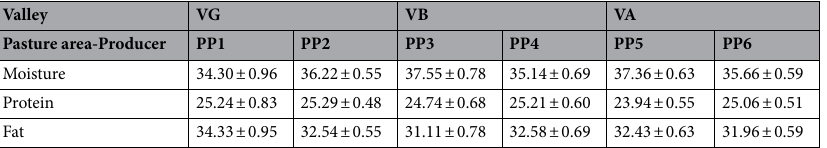
Historic Rebel cheese-associated microbiota was dominated by members of the Firmicutes phylum which accounted for about 99% of the entire abundance, with a minor presence of Proteobacteria. Carafa et al. 12 and Dalmasso et al. 6 noticed the same pattern in traditional mountain cheese produced with no starter strains in